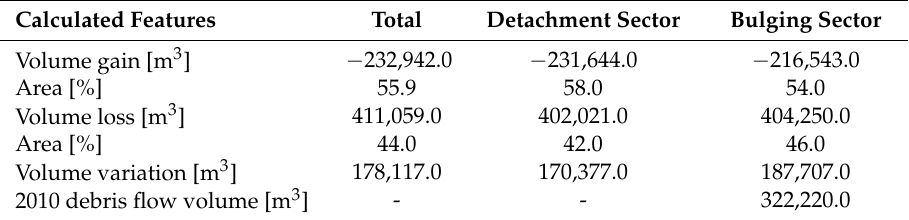
Table 1. Positive (Loss—removed material) and negative (Gain—accumulation) volume